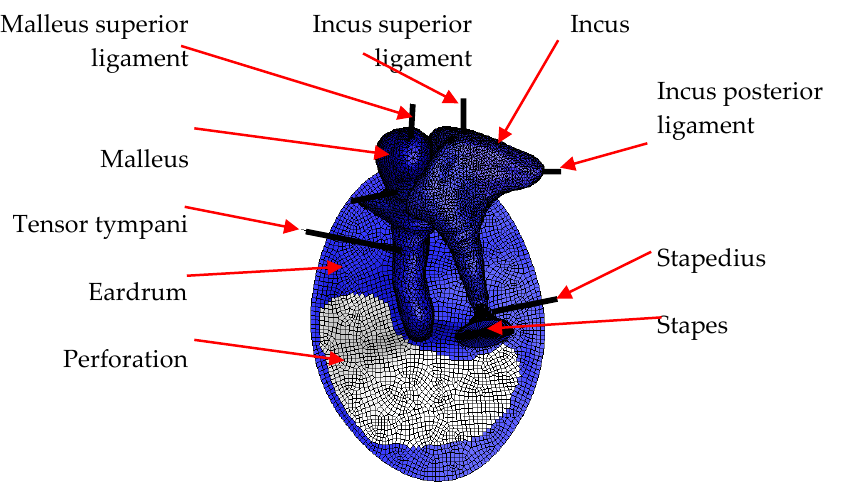
Figure 1. Visualization of an eardrum perforation occupying its inferior quadrants (of 7 mm).